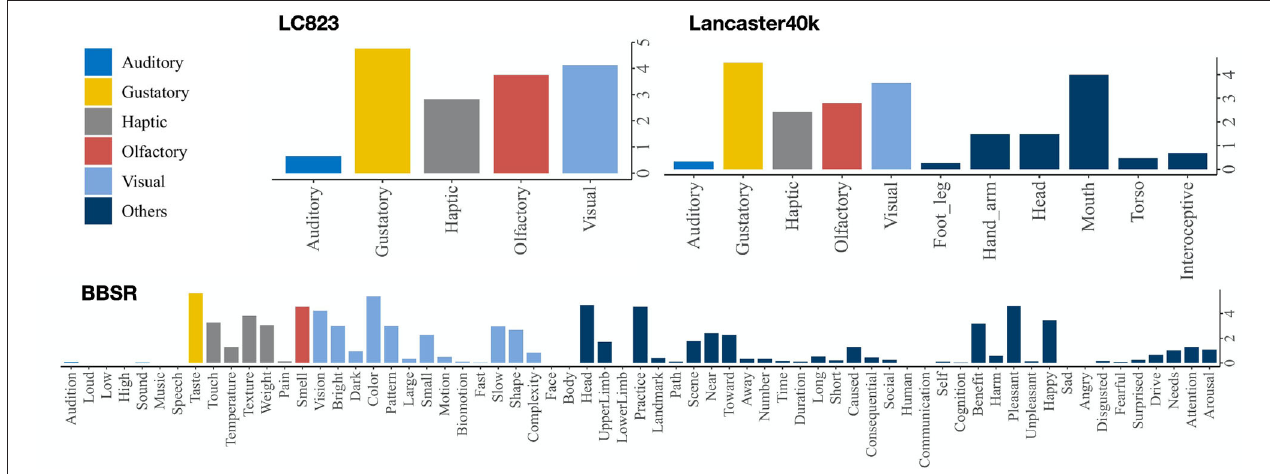
FIGURE 1 | The concept “honey” in multisensory datasets.